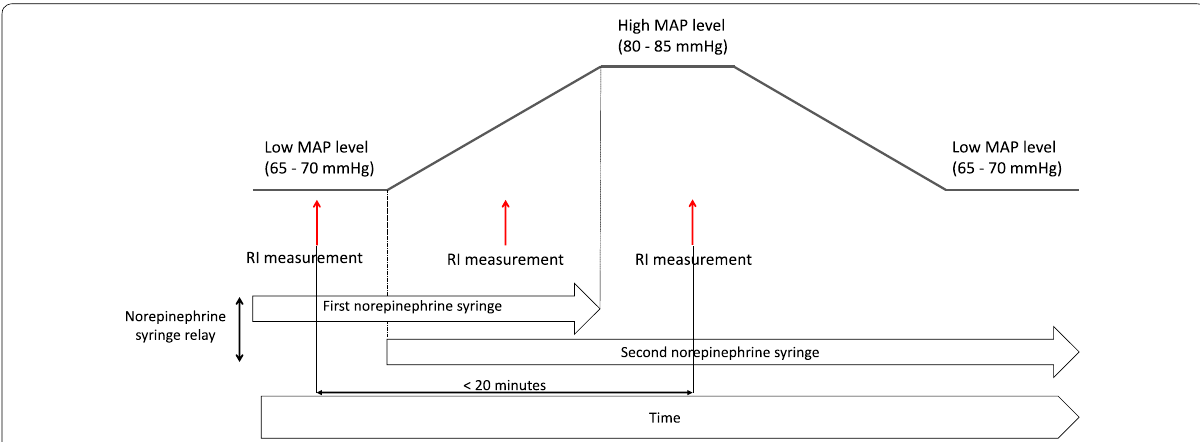
Fig. 1 Renal resistive index (RI) measurements and sequence of RI measurements. A RI measurement corresponded to the mean of five measures performed on five consecutive pulses at one mean arterial pressure (MAP) level. A sequence of RI measurements included from 2 to 5 RI measurements performed in less than 20 min at, at least, 2 MAP levels (aim of at least 15 mmHg apart, between the two levels). When vasopressors were discontinued, the sequence of RI measurements included only one RI measurement at one MAP